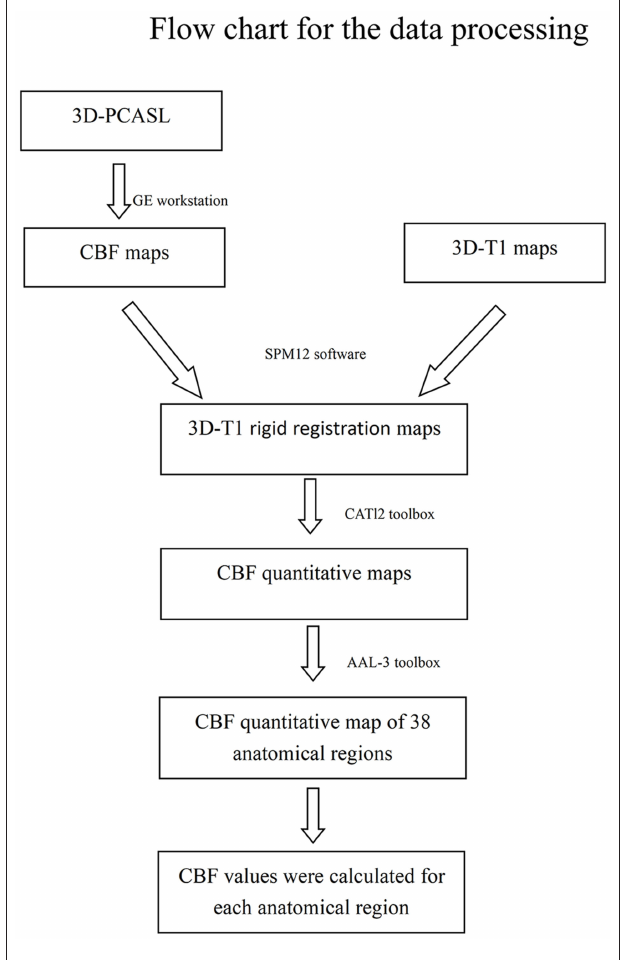
FIGURE 2 | Flow chart for the data